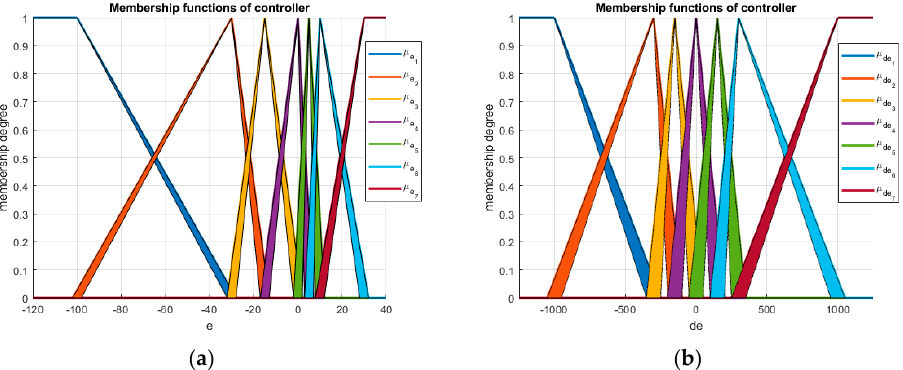
μ μ Figure 5. The membership functions for µ e and µ de . ( a ) The membership function µ e . ( b ) The and de . ( a ) The membership function Figure 5. The membership functions for e μ . membership function µ de . membership function de